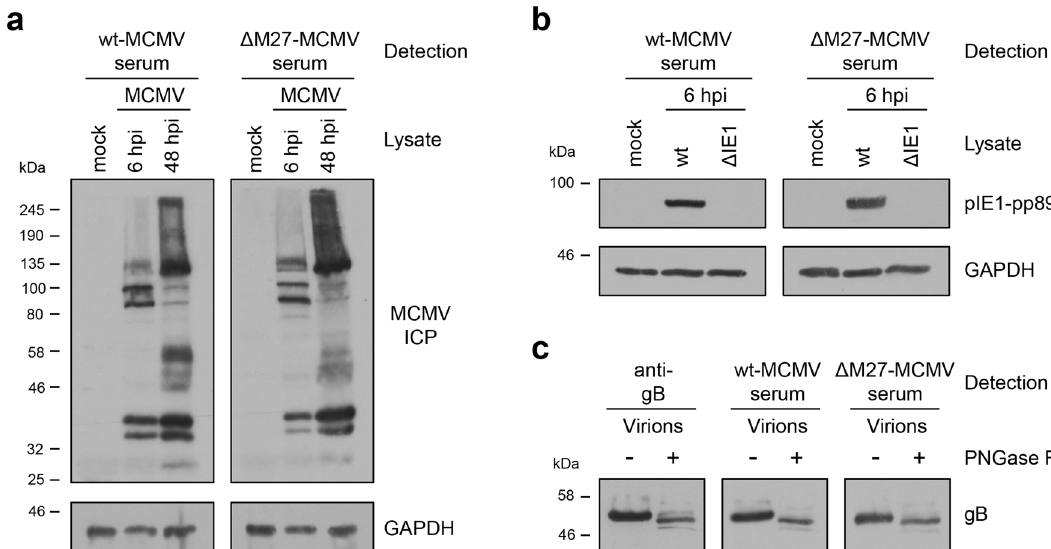
Fig. 4 Immunization with Δ M27-MCMV elicits antibody responses similar to wt-MCMV infection in terms of quantity and antigens recognized. BALB/c mice were infected i.p. with wt-MCMV or Δ M27-MCMV. At 21 dpi, serum samples were collected. Serum samples of 10 wt- MCMV and 10 Δ M27-MCMV-infected mice were pooled and used for the analysis of recognized MCMV antigens. a Mouse fi broblasts were infected with wt-MCMV. At 6 and 48 hpi, cells were lysed. b Mouse fi broblasts were infected with Δ IE1-MCMV 88 and the corresponding wt- MCMV control virus. At 6 hpi, cells were lysed. c Virus particles from the supernatant of wt-MCMV-infected fi broblasts were concentrated by ultracentrifugation through a 15% sucrose cushion and lysed. Lysates of concentrated virus particles were mock-treated or digested with